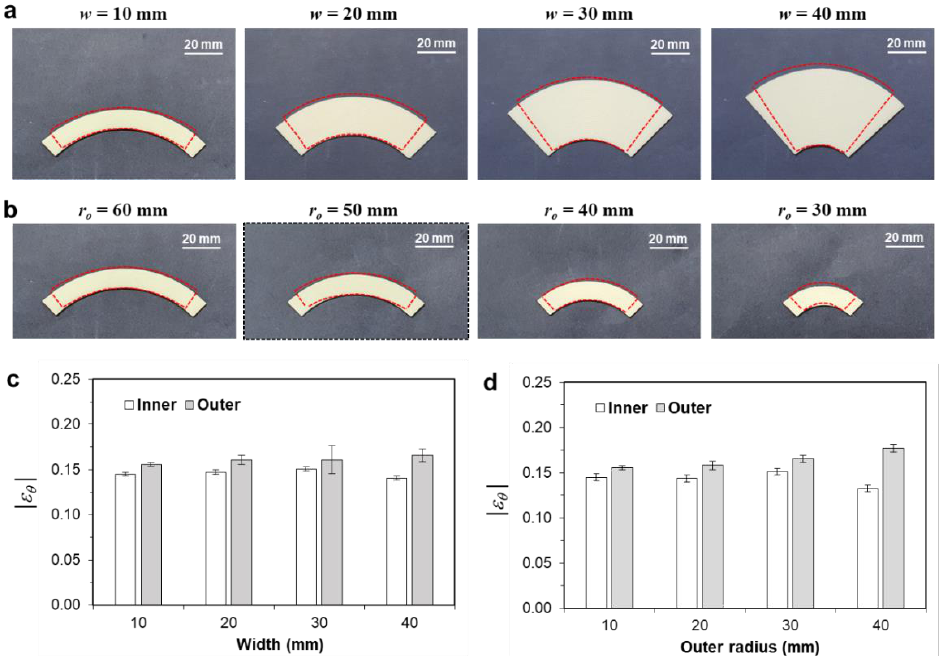
Figure 4. Comparison thermal deformation results of the partial annulus frame: ( a ) DEFORMED shapes with various annulus widths ( r o = 60 mm); ( b ) deformed shapes with various outer radii ( w = 10 mm); ( c ) comparison of the circumferential strains ( ε θ ) with various annulus widths; ( d ) com- parison of the circumferential strains ( ε θ ) with various outer radii. Here, the strain values are expressed as absolute